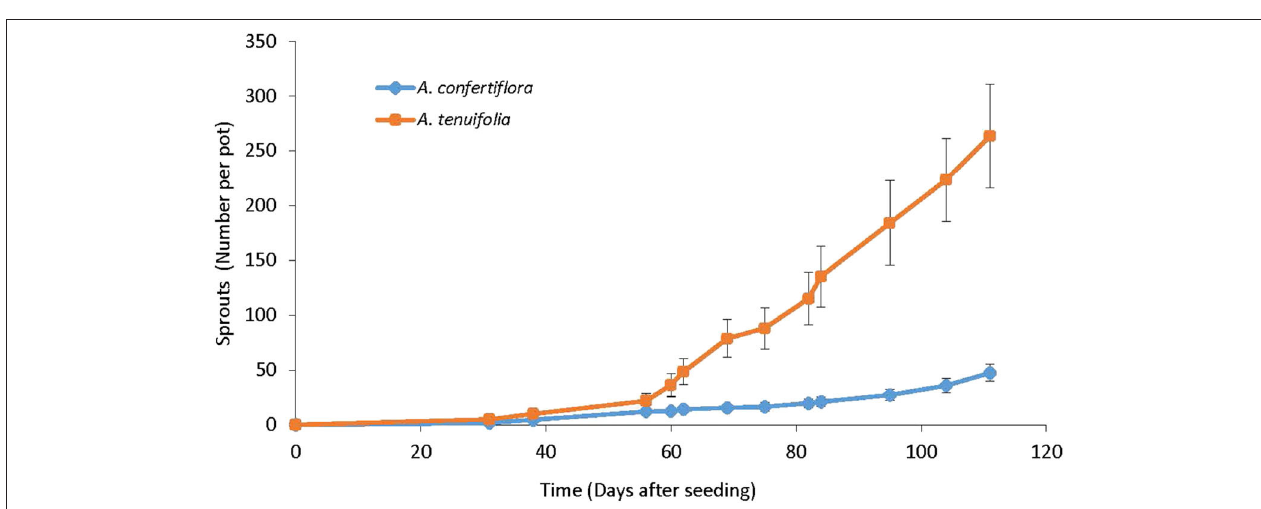
FIGURE 10 | Accumulated number of A. confertiflora and A. tenuifolia rhizome sprouts that developed over time in pots in the net house from August to November, 111 DAS. Error bars represent the Standard Error of the means.